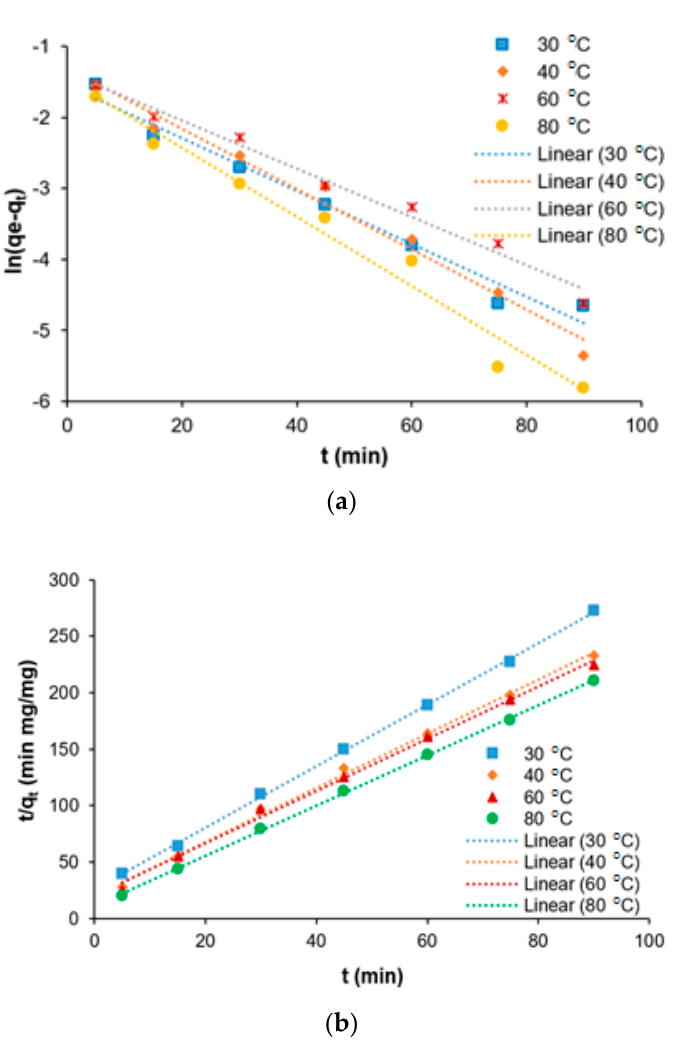
Figure 11. Adsorption kinetics studies for the removal of SS from SRPE using FeSO 4 ·7H 2 O as a coagulant. ( a ) Pseudo-first-order kinetics model and ( b ) pseudo-second-order kinetics model.